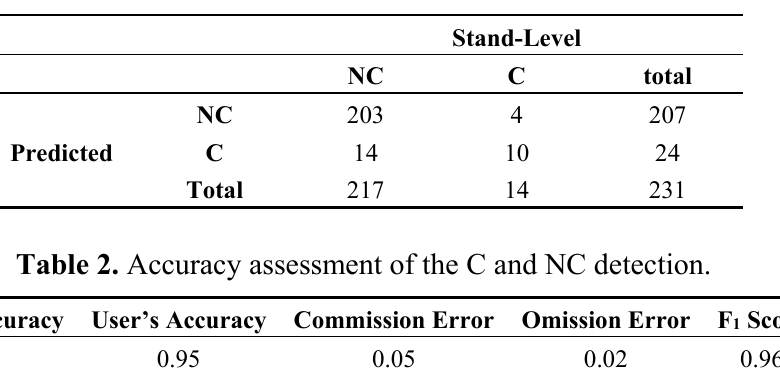
Table 1. Error matrix of the C and NC detection.